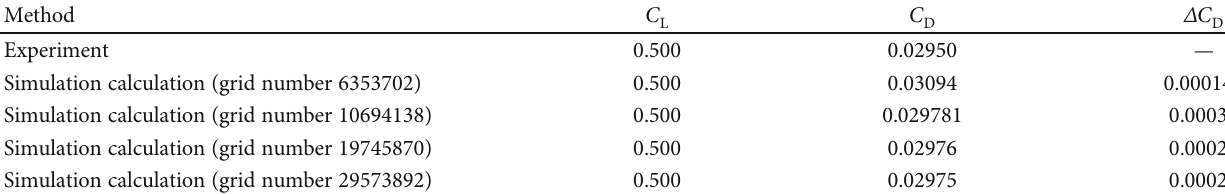
Table 2: Comparisons between predictions of CFX and test